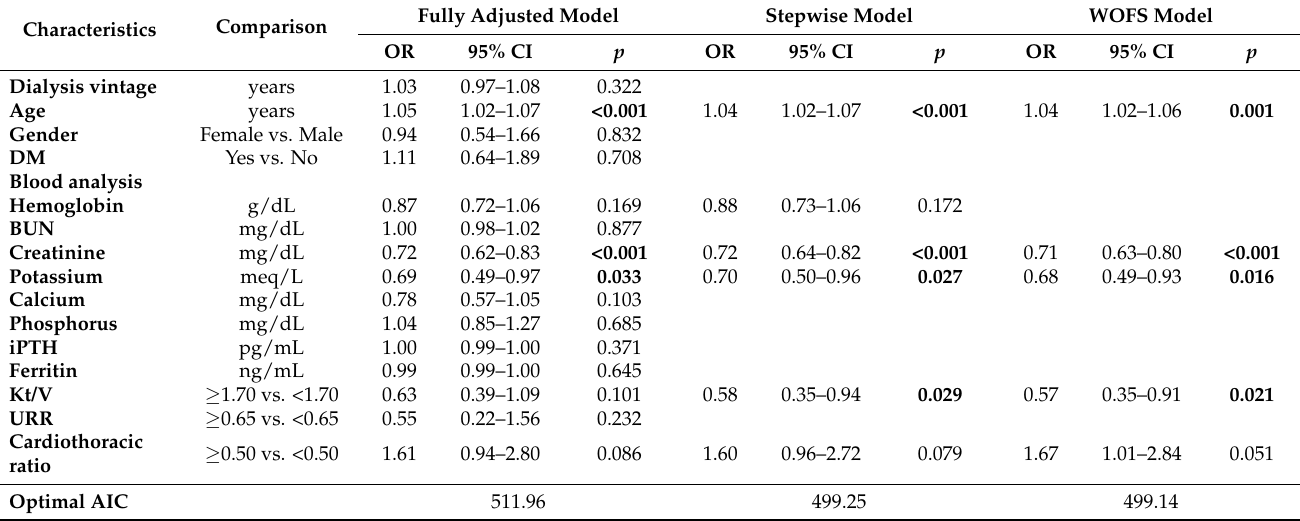
Table 3. Multivariate logistic regression analysis for time-averaged serum albumin (TSA) category based on different feature selection